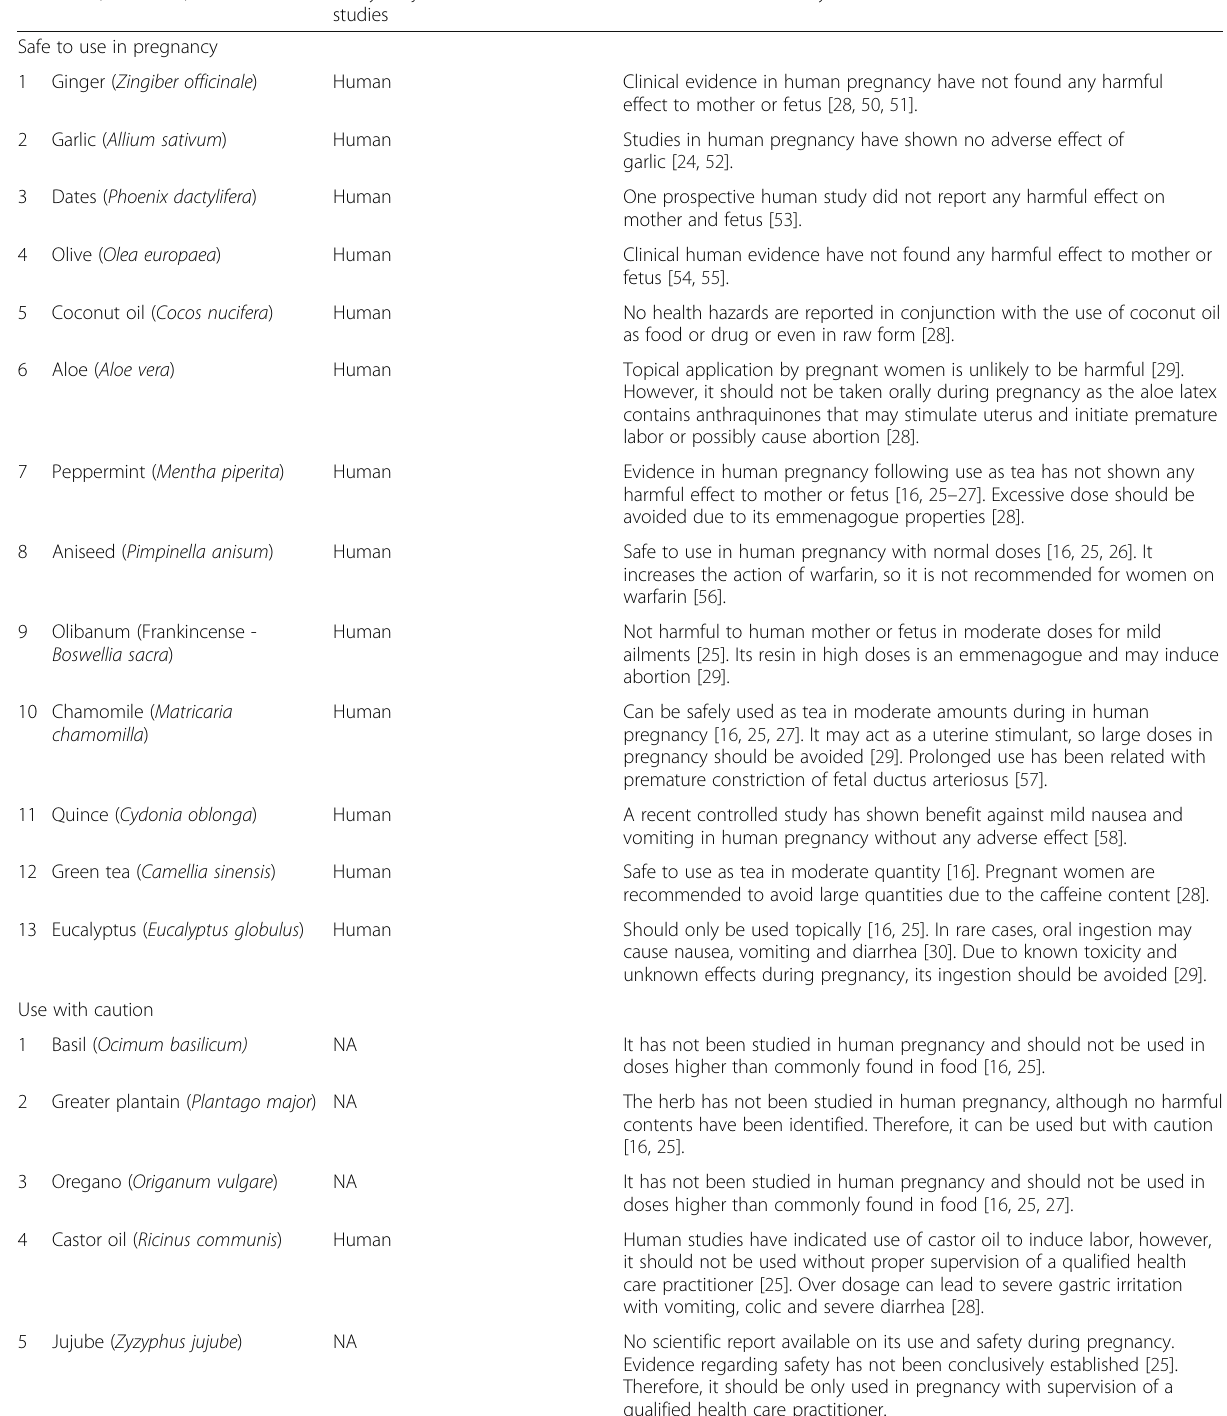
Table 5 Documentation on safety of most frequently used herbs during pregnancy Sr. Herb (or